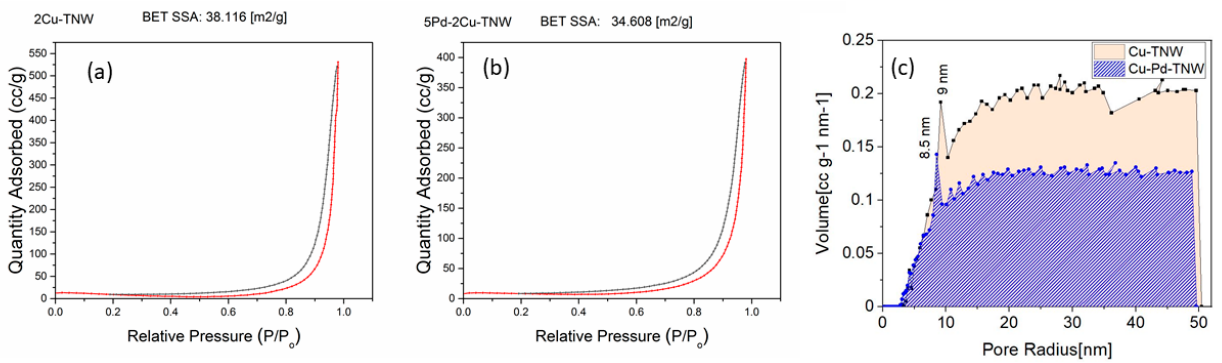
Figure 3. N 2 adsorption–desorption isotherms over ( a ) Cu-TNW; ( b ) Pd-Cu-TNW catalysts; ( c ) BJH pore size distribution.